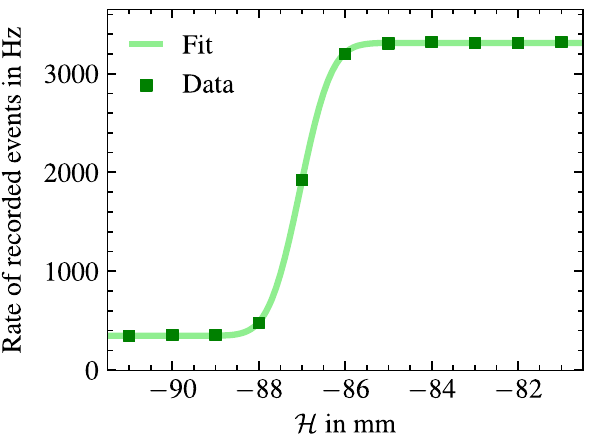
Fig. 7 Rate of events in the segBEGe detector as determined from 1min measurements as a function of the horizontal motor position, H , at A = 0 ◦ . The statistical uncertainties would be hidden by the markers and are not shown